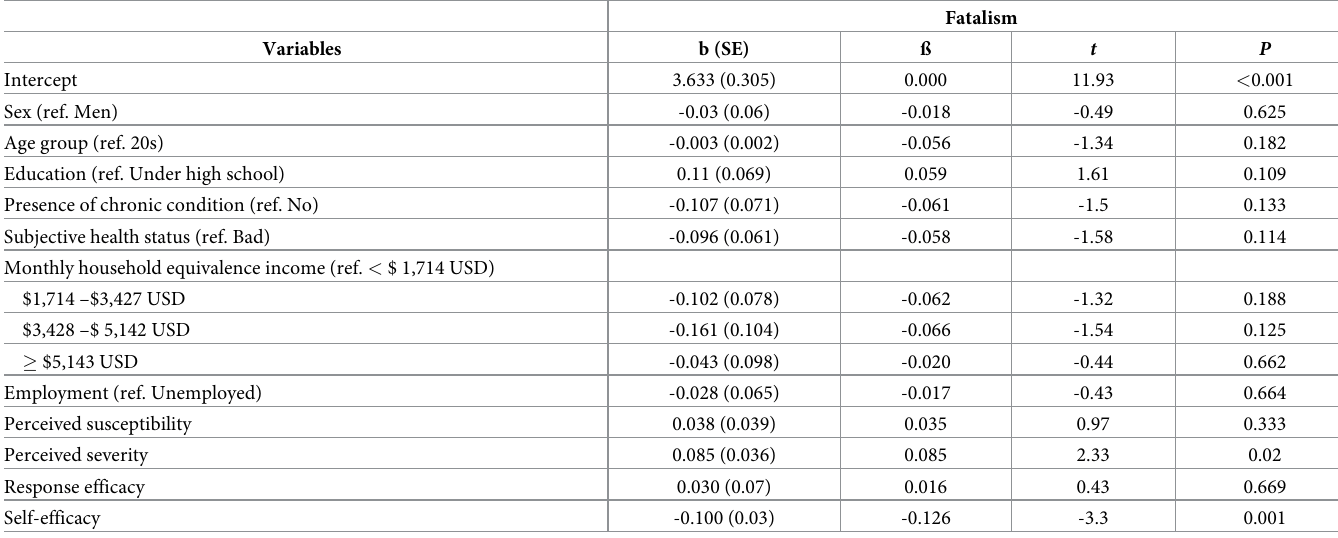
Table 3. Multiple regression analysis with the variables predicting fatalism.